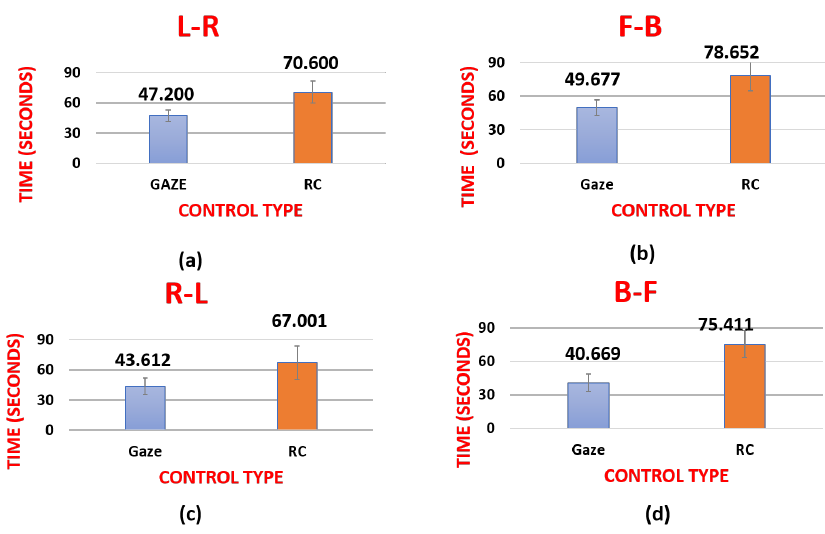
Figure 8. Mean time-to-complete Experiment 1 with: ( a ) variation 1 (L-R), ( b ) variation 2 (B-F), ( c ) variation 3 (R-L), and ( d ) variation 4